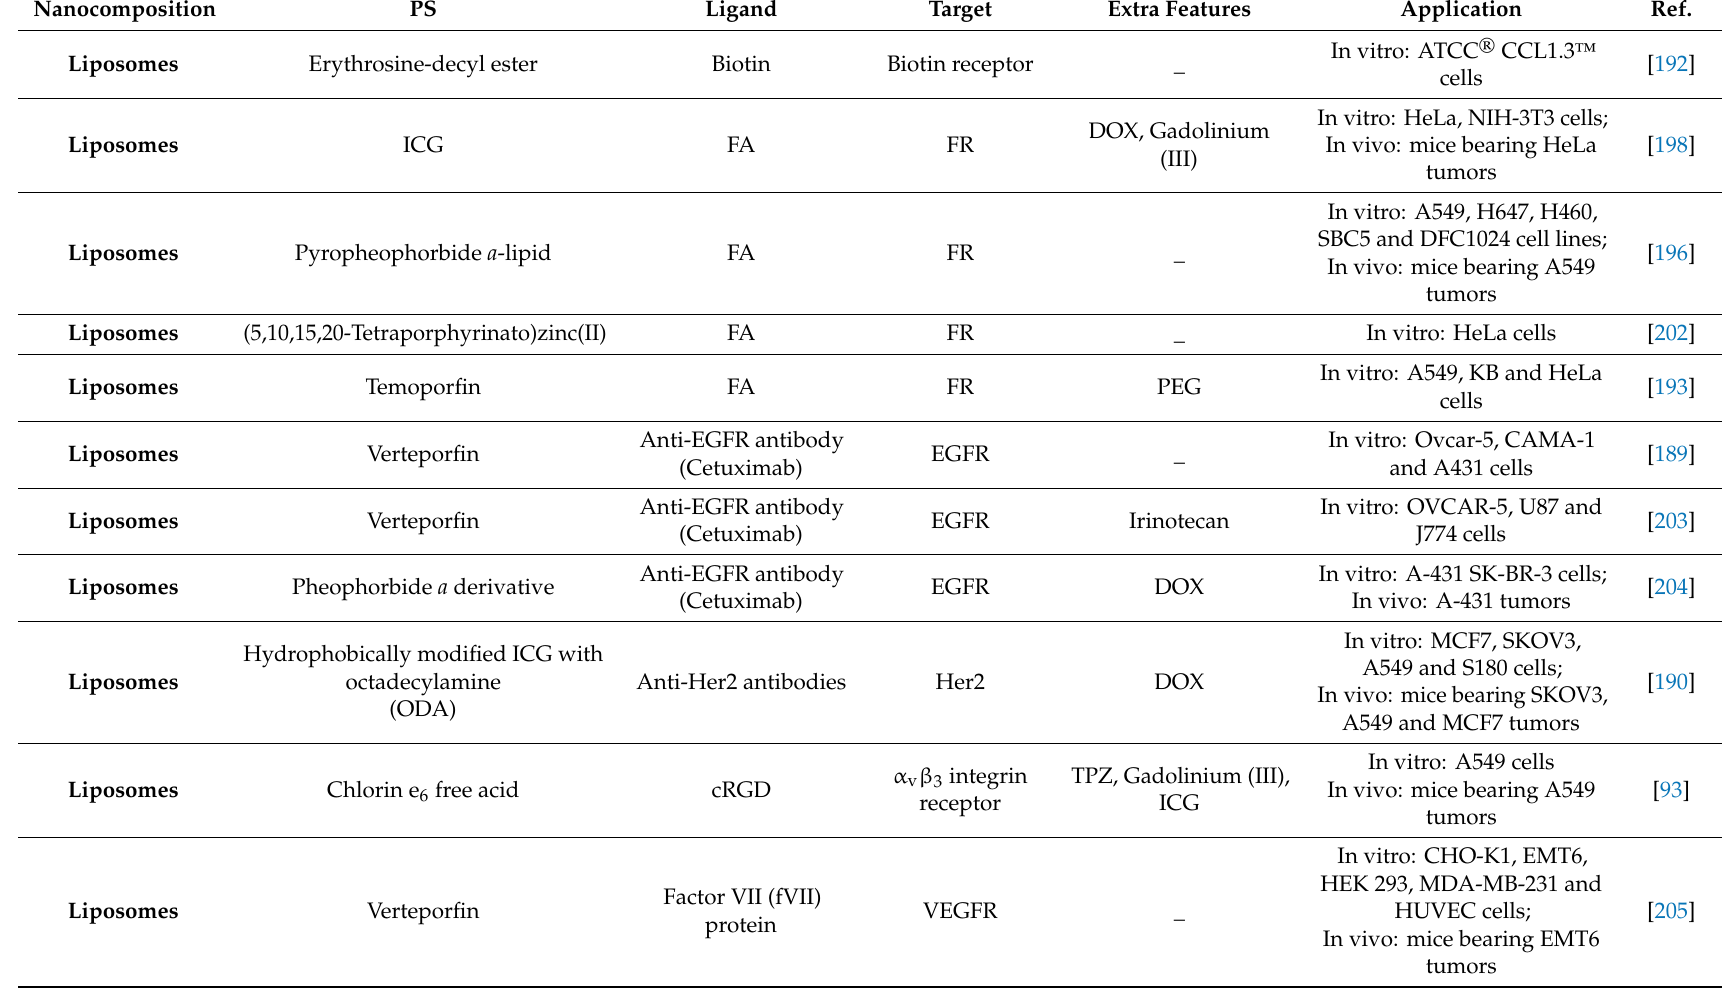
Table 4. Examples of ligand-targeted lipid-based NPs for photodynamic therapy